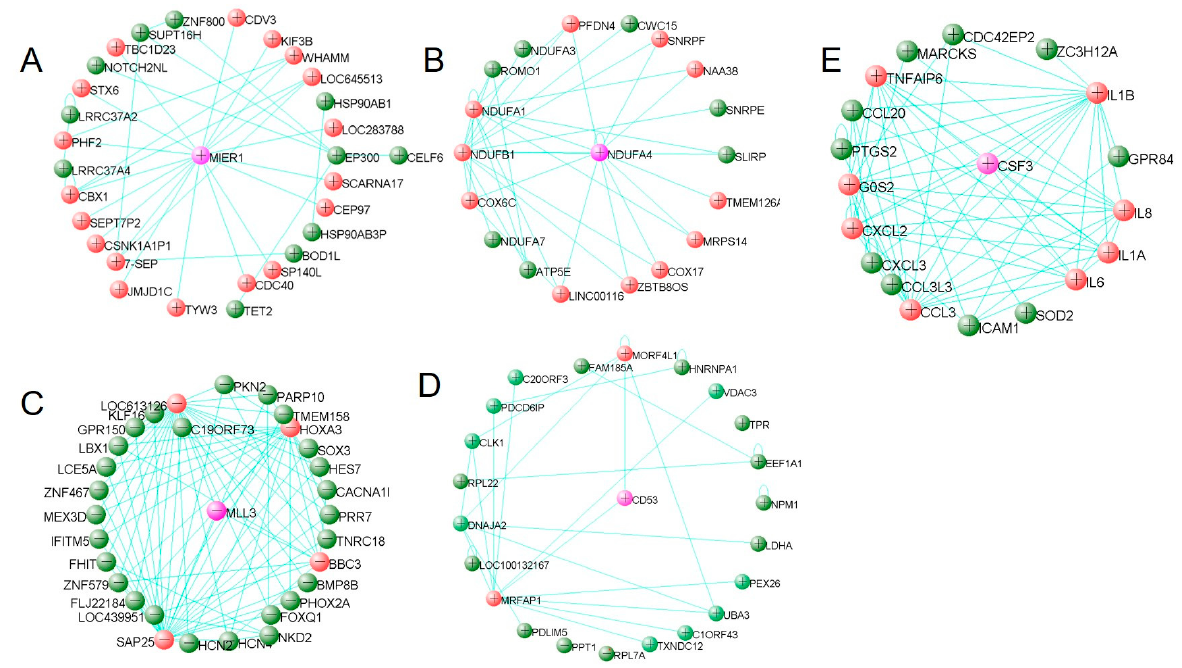
Figure 5. The hub genes and feature genes from each of the five modules. ( A ) 30 hub genes identified as strongly connected in purple module with weight cutoff at 0.08. ( B ) 19 hub genes identified as strongly connected in darkolivegreen module with weight cutoff at 0.08. ( C ) 35 hub genes identified as strongly connected in turquoise module with weight cutoff at 0.41. ( D ) 21 hub genes identified as strongly connected in saddlebrown module with weight cutoff at 0.09. ( E ) 19 hub genes identified as strongly connected in salmon module with weight cutoff at 0.20. Among these hub genes, the feature gene was colored purple and the hub genes directly correlated with the feature gene at the current weight cutoff value were colored red.